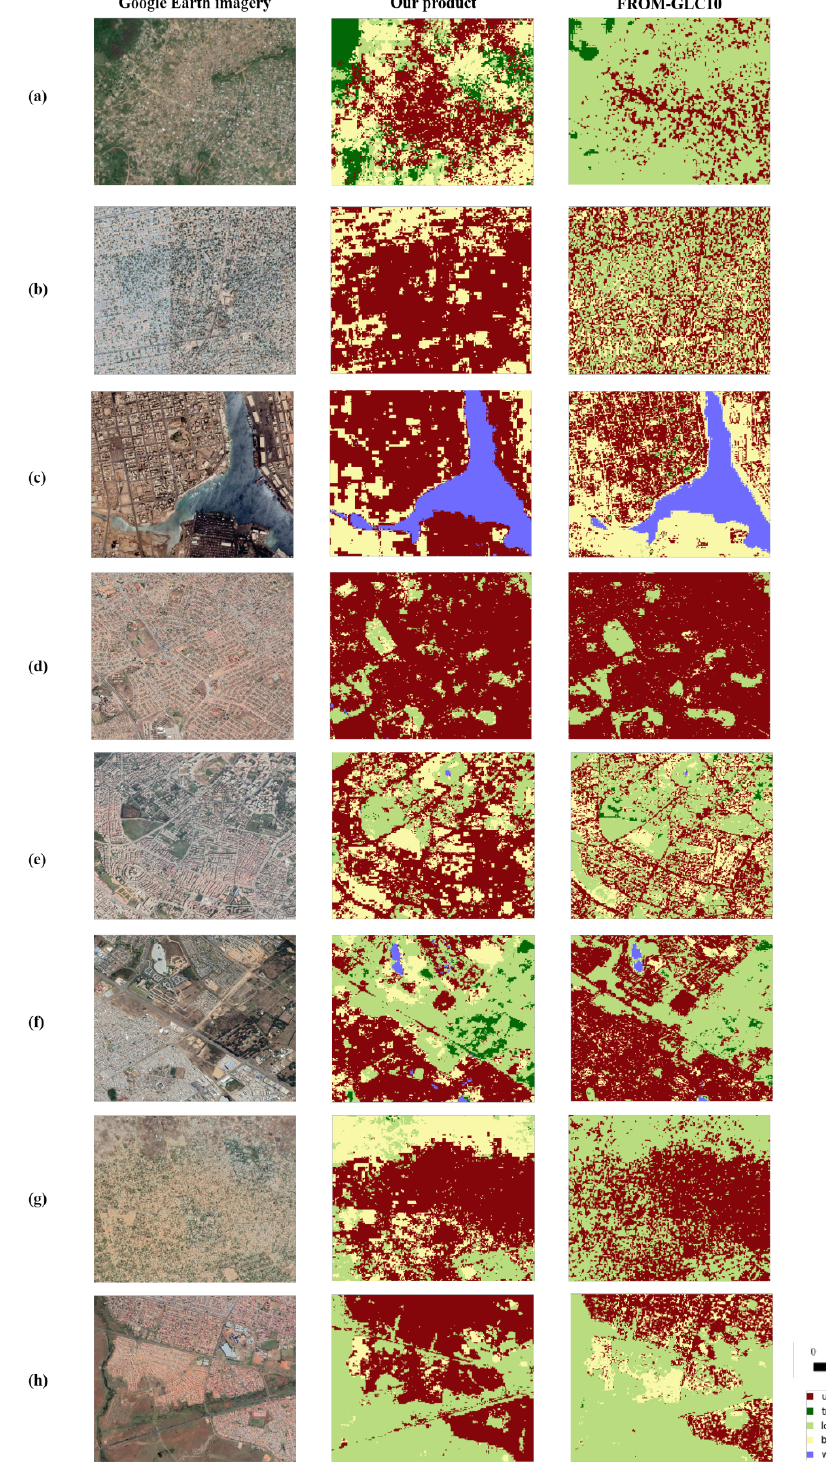
Figure 10. Google Earth imagery, our product, and the From-CLC10 product of the urban area in the climate zone from ( a ) Tropical wet climate (Aw), ( b ) Hot semi-arid climate (BSh), ( c ) Hot desert climate (BWh), ( d ) Temperate oceanic climate (Cfb), ( e ) Hot-summer Mediterranean climate (Csa), ( f ) Warm-summer Mediterranean climate (Csb), ( g ) Monsoon-influenced humid subtropical climate (Cwa), and ( h ) Subtropical highland climate